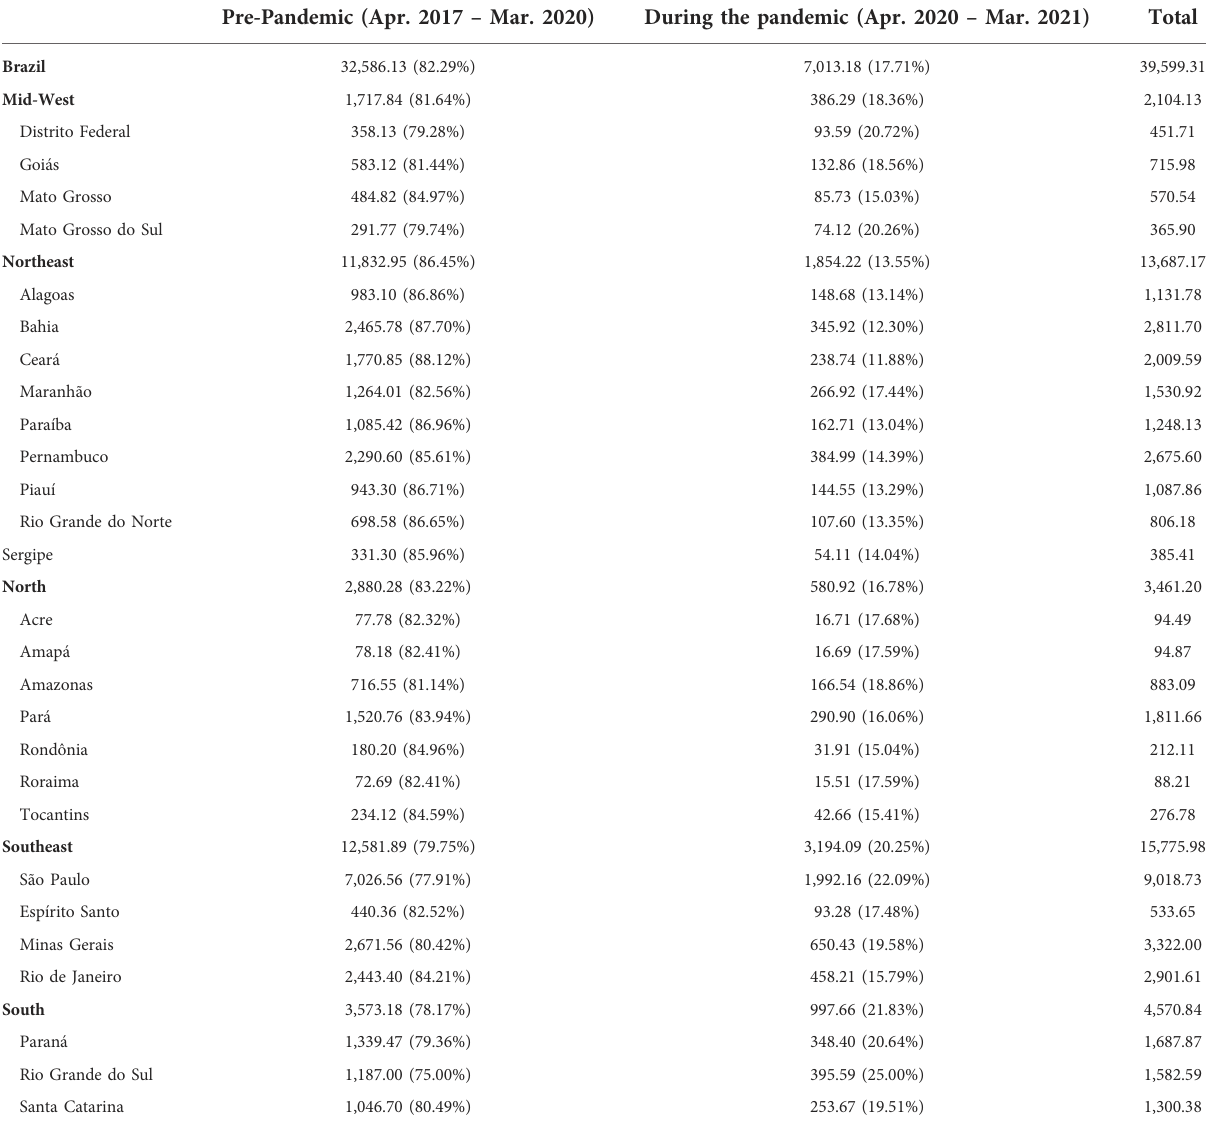
TABLE 1 Number of visits before and during the pandemic, according to regions, states, and the Federal District.